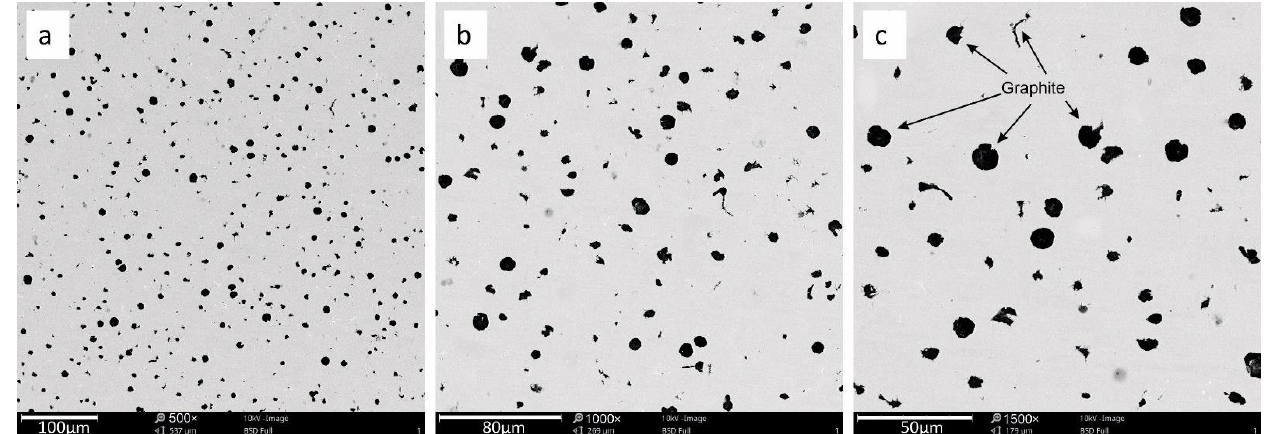
Figure 1. The cast iron microstructure for sample 1 with precipitation of nodular and vermicular graphite. Magnification 500× ( a ), 1000× ( b ), 1500× ( c ).